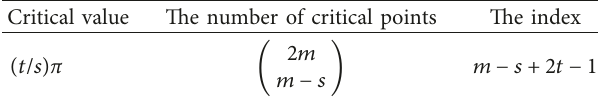
Table 1: The information on μ at ( s,t ) . Critical